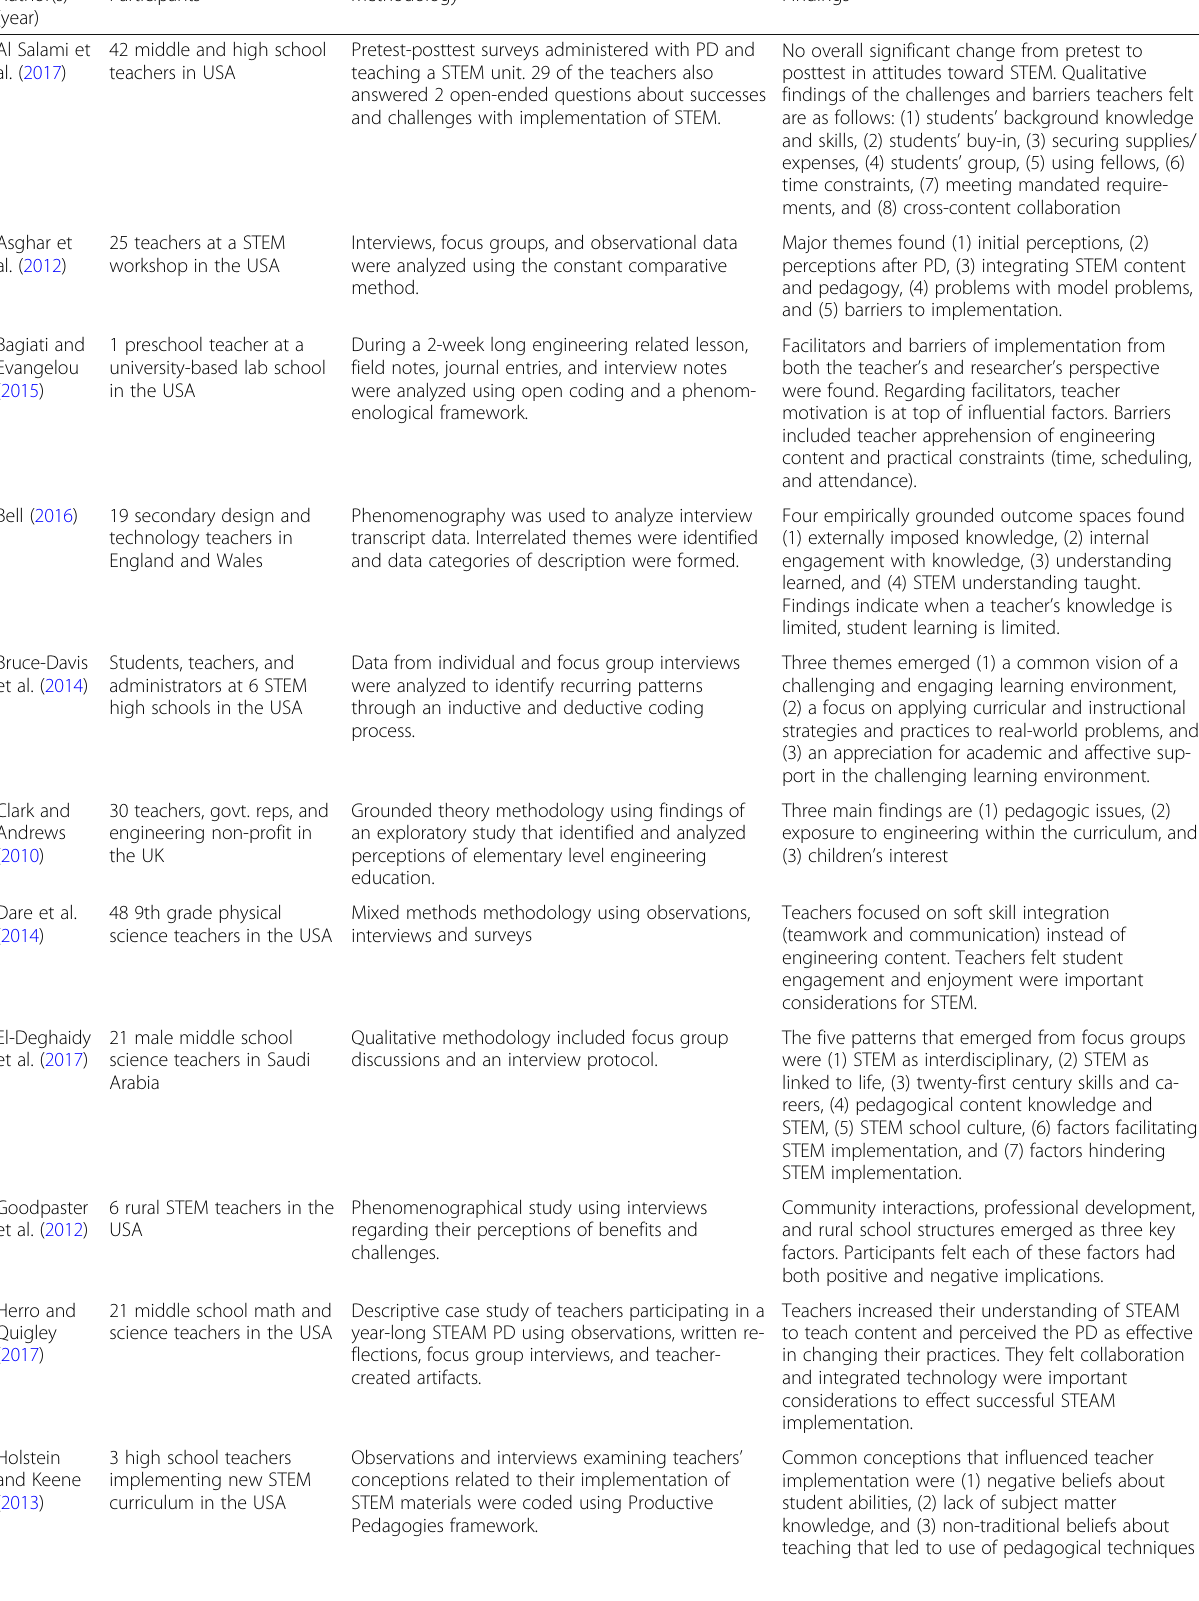
Table 4 Summary of included empirical